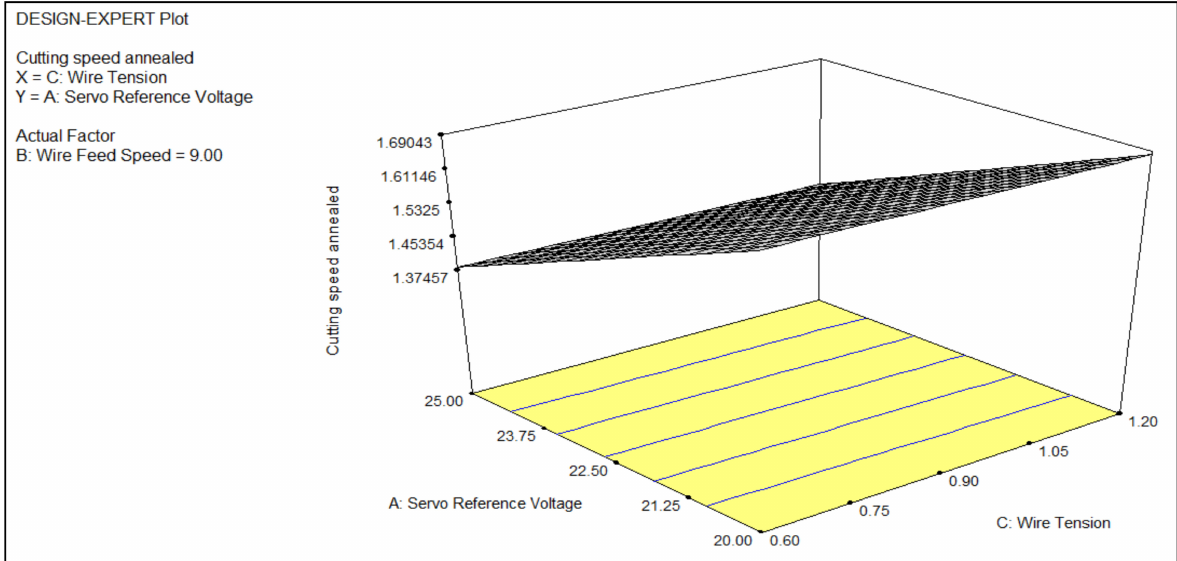
Figure 6. A 3D plot of the cutting speed as a function of the wire tension and servo reference voltage.